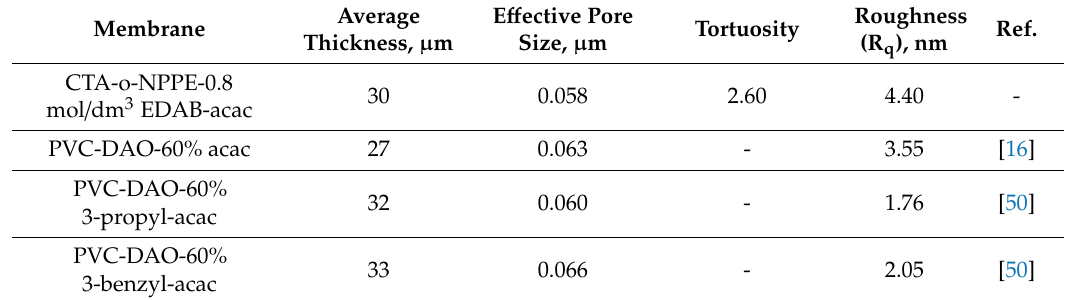
Table 2. Parameters characterizing membranes doped with ethylenediamine-bis-acetylacetone (EDAB-acac) and acetylacetone (acac).